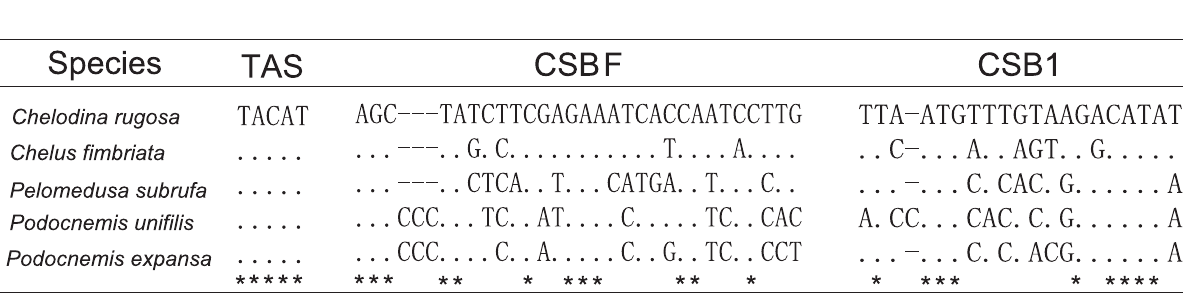
Figure 1. The alignment of TAS and conserved blocks from five pleurodiran turtles. Note: Dots indicate same nucleotides as top se- quences, and asterisk shows the identical